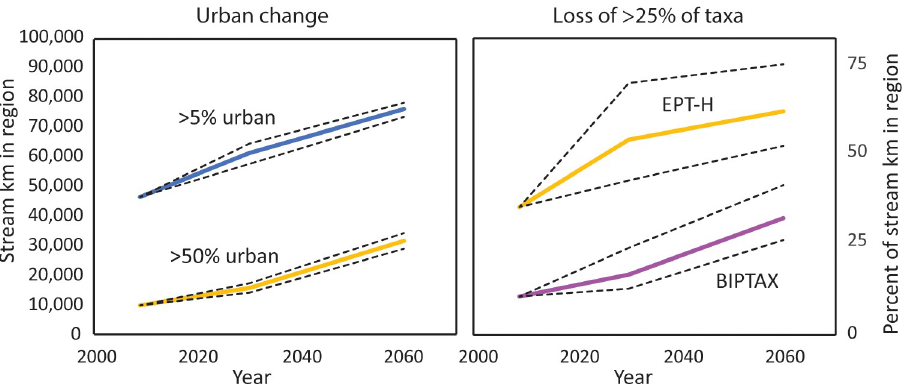
Fig 2. Projected change in urban land use in the Piedmont ecoregion to 2060 (left) and resulting loss of invertebrate (EPT-H) and fish (BIPTAX) taxa (right). Upper, middle, and lower lines for each threshold are 20, 50, and 80% probability of land being urban, respectively. The length and percent of stream kilometers in the region expected to lose > 25% of taxa based on land-use change (solid lines); dashed lines represent the 95% confidence interval of the